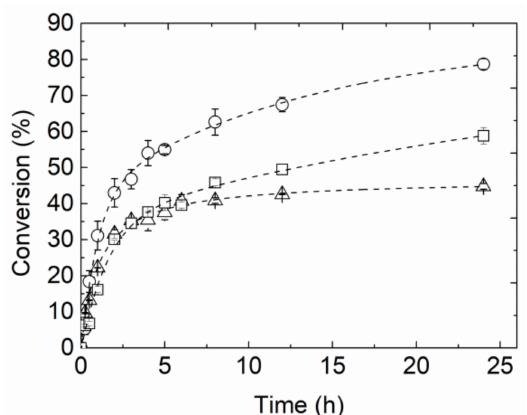
Figure 3. Hydrolysis of birchwood xylan soluble fraction (25,4 g/L) by the studied xylanases (150 IU/g xylan = 3810 IU/L) at 50 ◦ C, 24 h, pH 5.6. XynA ( ∆ ); Multifect ( standard errors of